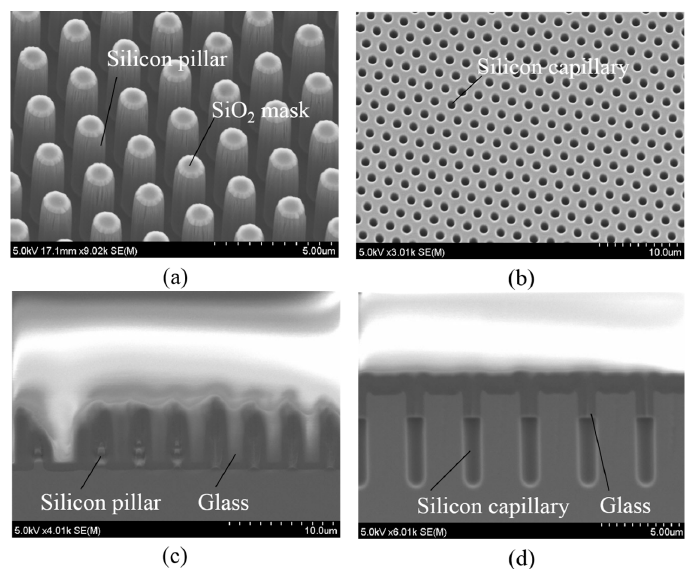
Figure 12. Glass reflow process into small cavities. ( a ) Silicon pillar mold; ( b ) silicon capillary mold; ( c ) penetration depth of pillar mold under third reflow condition; ( d ) penetration depth of capillary mold under third reflow condition. Table 5. Summarized parameters of pillar and capillary molds.